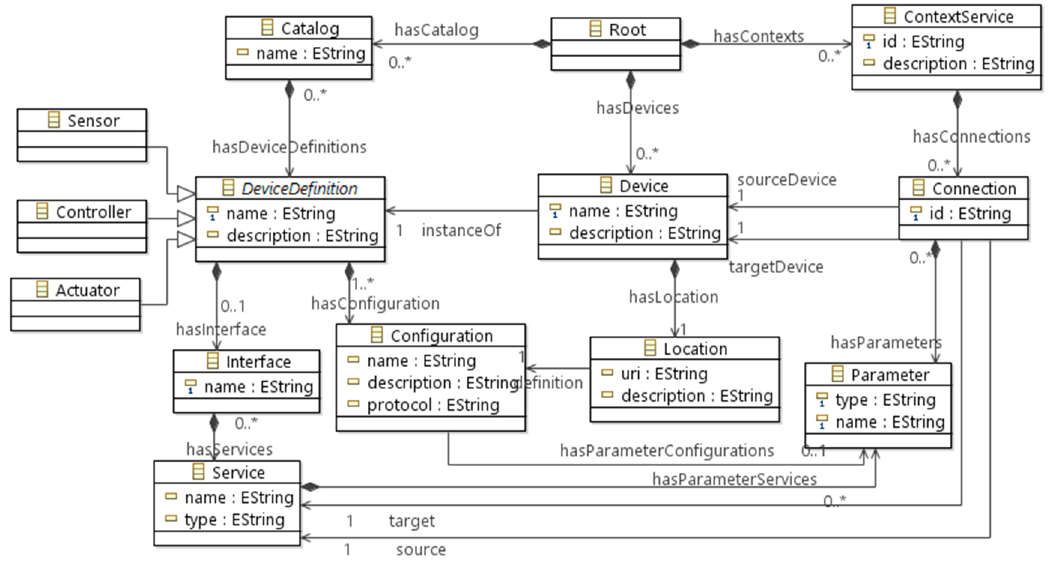
Figure 1. Smart City DSL